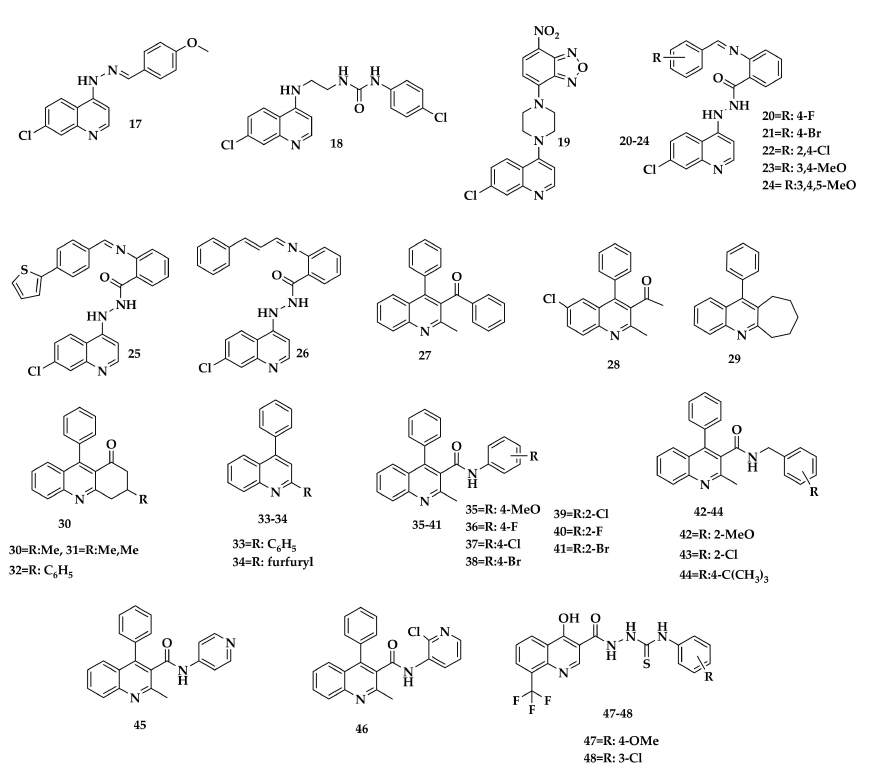
Figure 16. Chemical structures of quinoline-based compounds studied in this